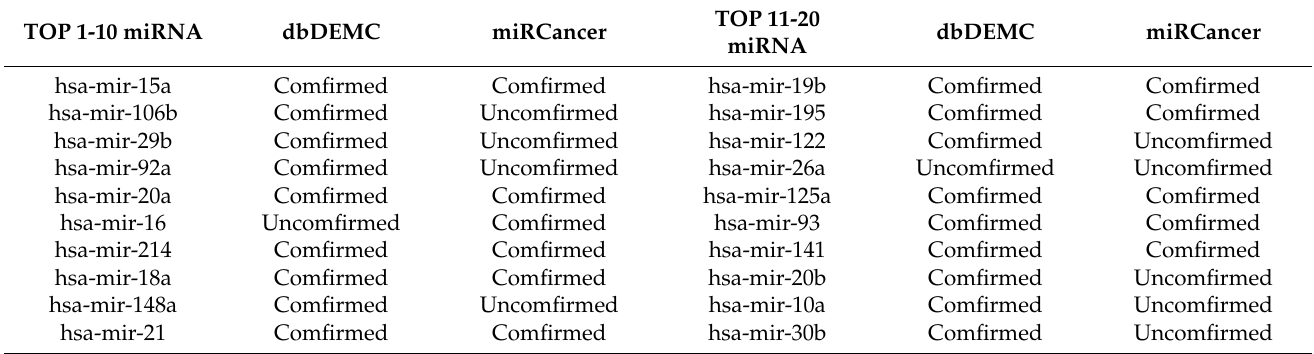
Table 7. Top 20 colon neoplasm-related miRNAs predicted by SGAEMDA based on HMDD v2.0.